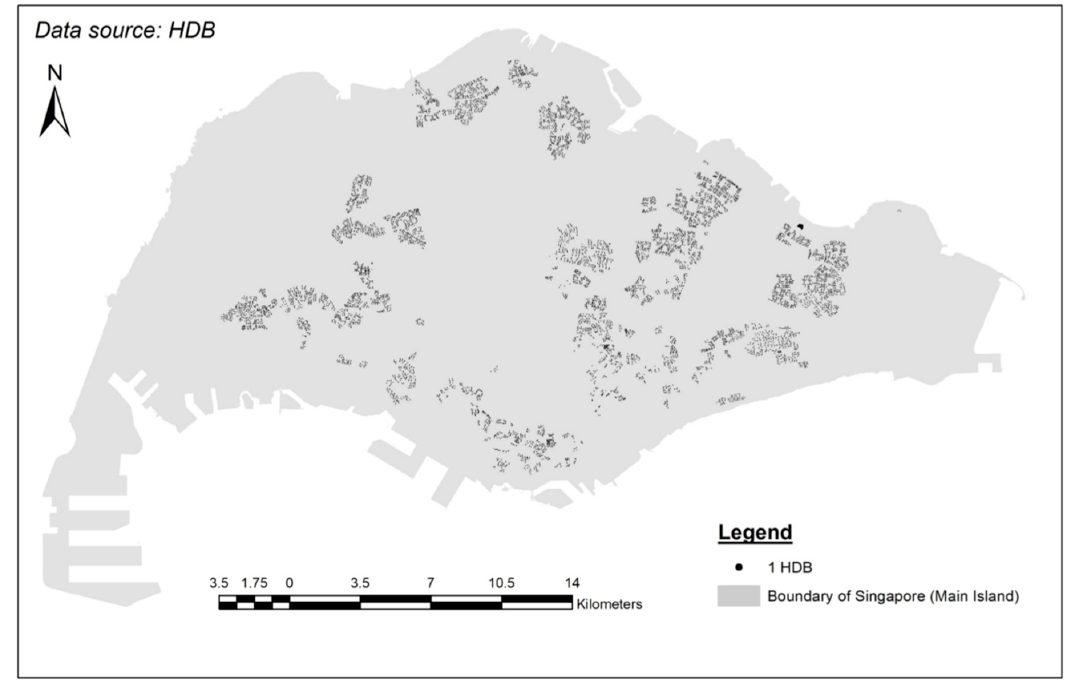
Figure 2. Map of HDBs in Singapore.